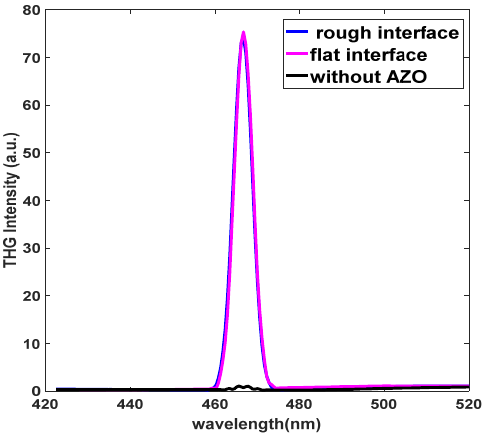
Figure 7. Transmission spectrum of THG in x and y polarization (cid:2869) = 𝐼 𝑆 𝑅𝑒(𝐸 × 𝐻 ∗ ) , 𝐼 In the simulation, 𝑃 , 𝐼 = is the peak intensity of the (cid:3104) (cid:3104) (cid:3048)(cid:3041)(cid:3036)(cid:3047) (cid:3104) (cid:2870) pump light, 𝑆 is the area of the structural unit cell, E is the pump electric field, and (cid:3048)(cid:3041)(cid:3036)(cid:3047)